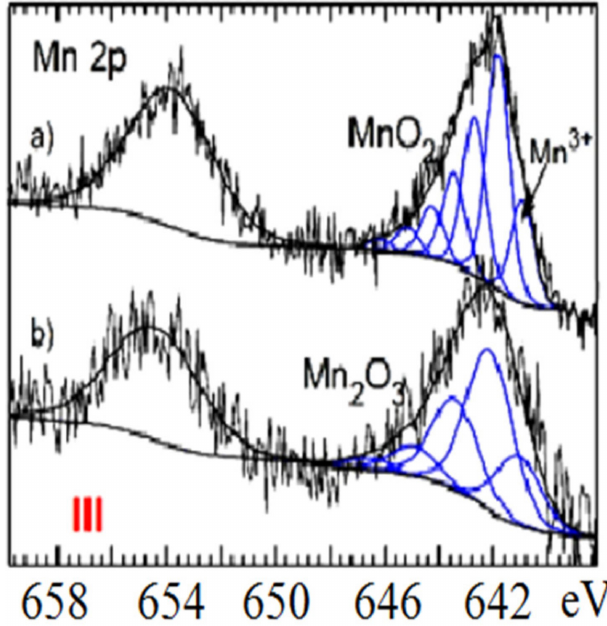
Figure 4. Mn2p core level spectra of ( a ) MnO 2 -zeolite and ( b ) Mn 2 O 3